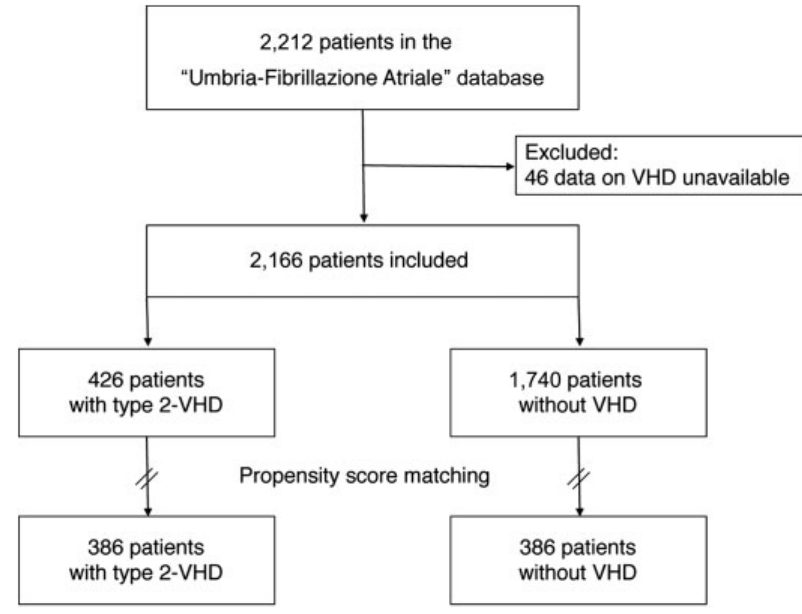
Fig. 1 Flow diagram of the study population. VHD, valvular heart disease.